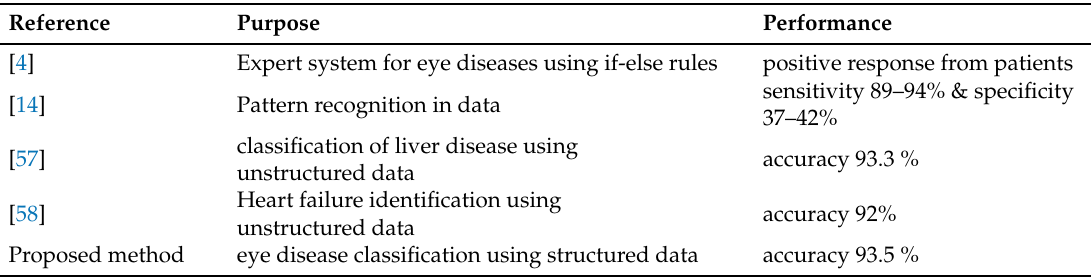
Table 8. Performance